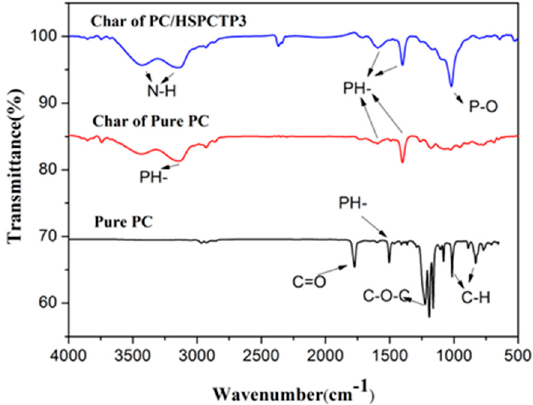
Figure 8. FTIR spectrum of the residual char of Pure PC, PC / HSPCTP3 composites obtained after the cone calorimeter test.